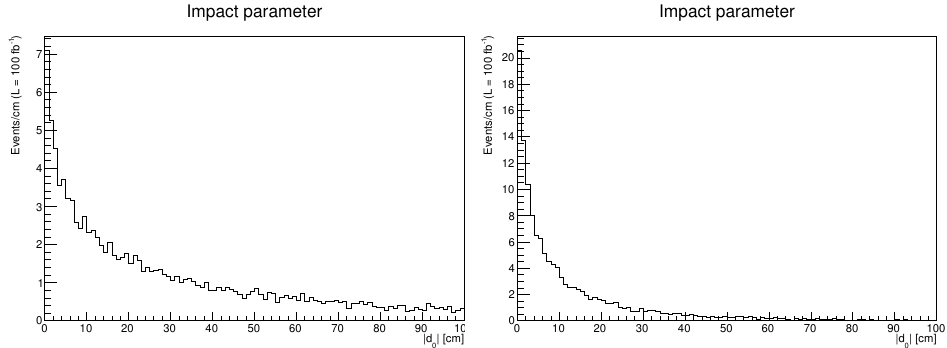
Figure 7. Impact parameter distribution for (a) BP2 and (b) BP4 of table 1. The heavy neutrino proper decay lengths are, respectively, 2 m and 0.5